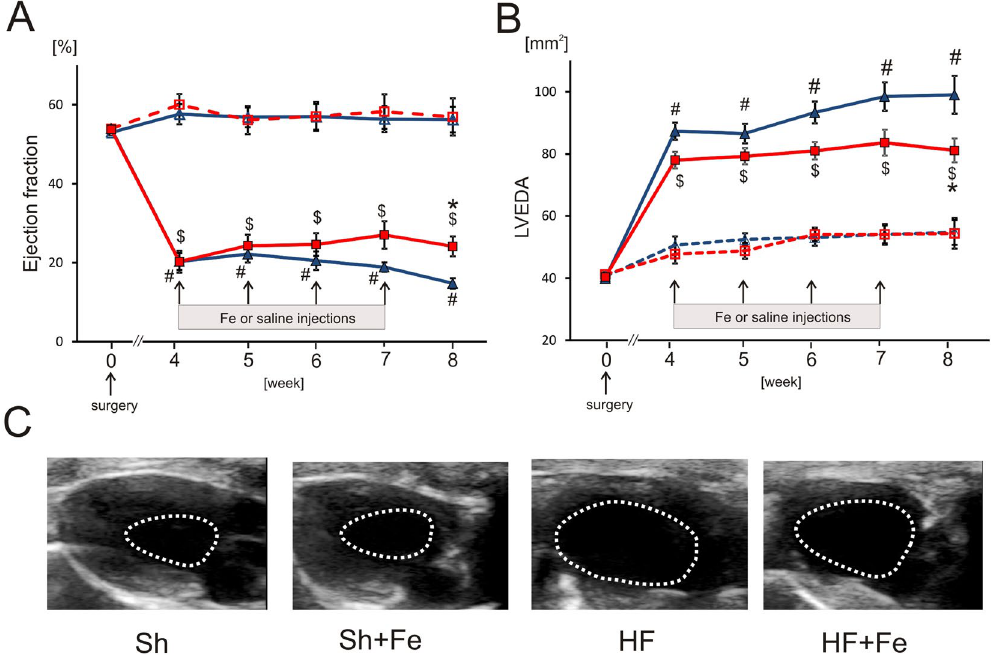
Figure 2. The effect of intravenous iron (Fe) supplementation on echocardiographic parameters in sham- operated (Sh) and heart failure (HF) rats. ( A ) Ejection fraction calculated as (LV end-diastolic area - LV end- systolic area)/LV end-diastolic area planimetered from the long-axis view. ( B ) left ventricular end-diastolic area (LVEDA); ( C ) the representative echocardiographic images of LV end-diastolic area from the long-axis view. Data is represented as mean ± SEM, n = 10 rats in each group, # p < 0.05 vs. Sham, $ p < 0.05 vs. Sham + Fe, * p < 0.05 vs.